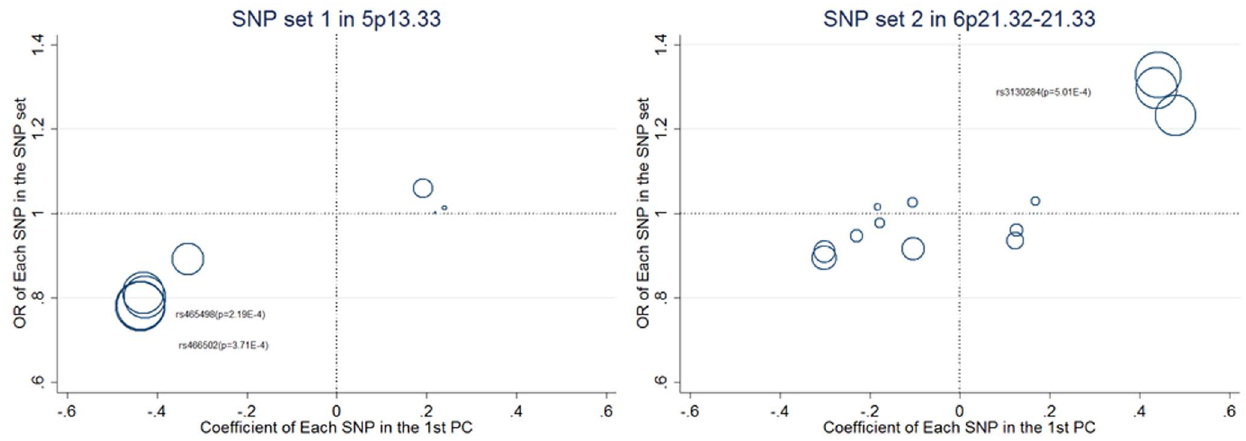
Figure 5. Loadings of the significant PCs on each of the SNP sets from 5p13.33 and 6p21.32–21.33. The diameters of the circles in the plots are proportional to 2 log10( p -value).